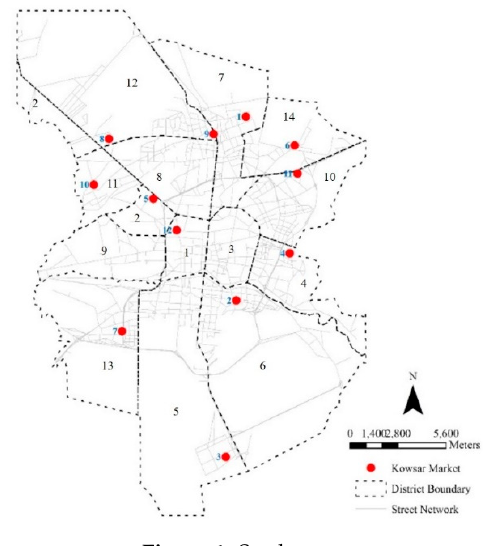
Figure 1. Study area.